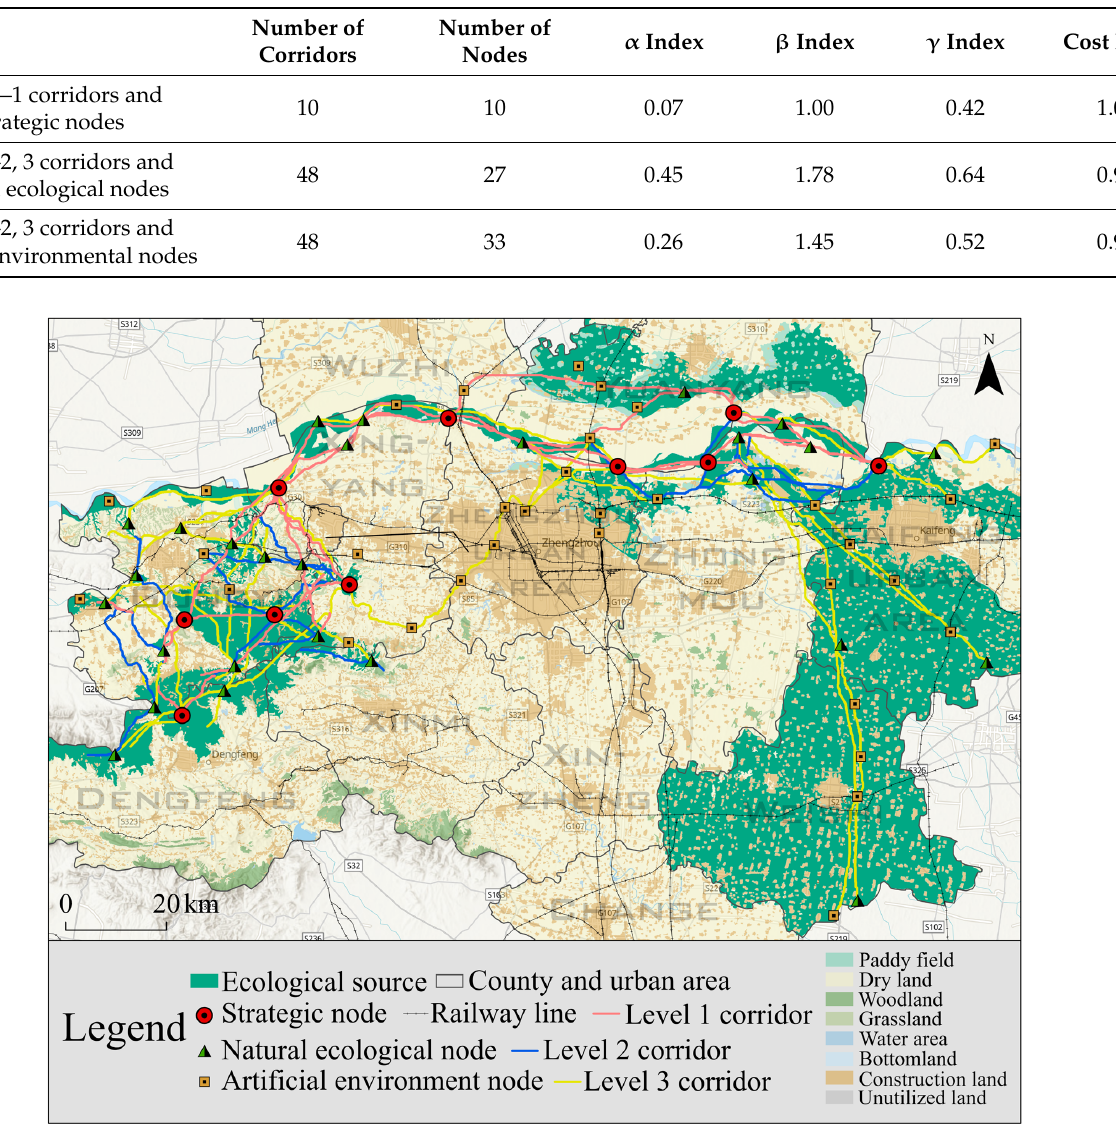
Figure 9. Construction of the ecological